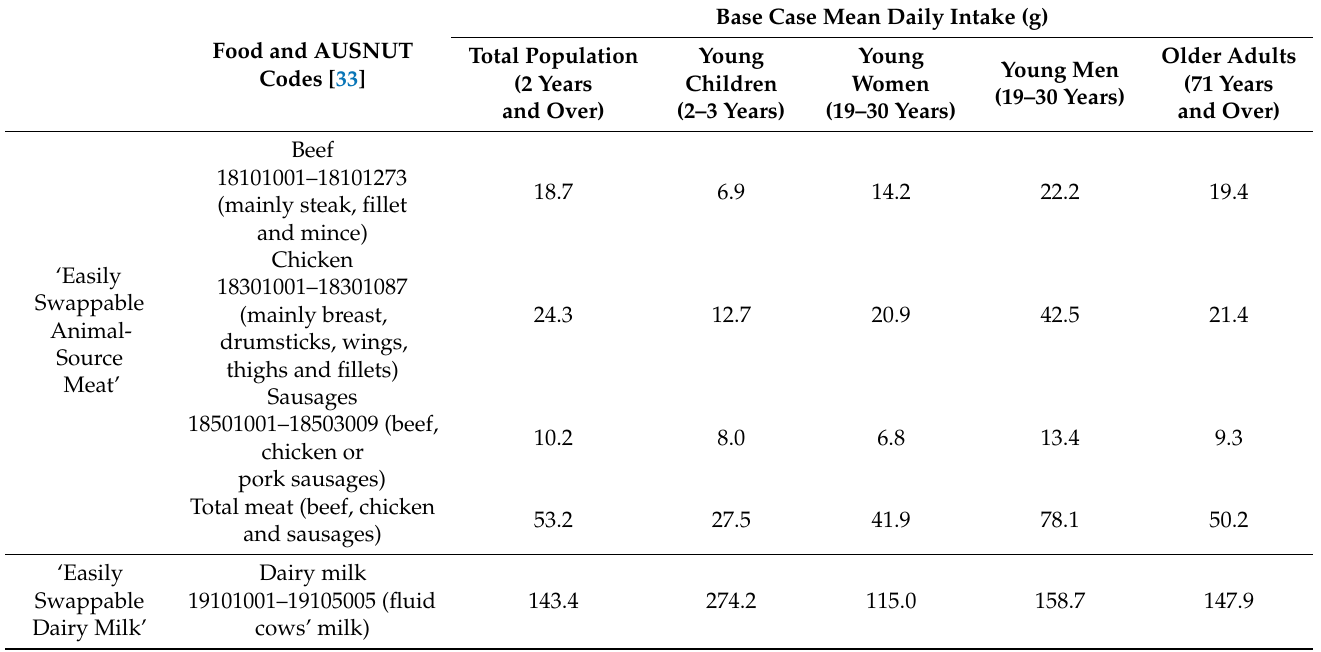
Table 1. Base case mean consumption of ‘Easily Swappable Animal-Source Meat’ and ‘Easily Swap- pable Dairy Milk’ in the Australian National Nutrition and Physical Activity Survey 2011–12.